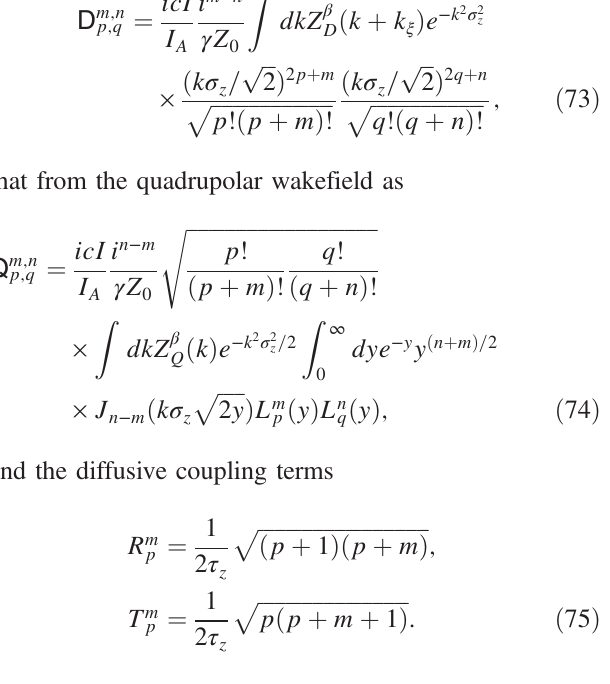
ffiffiffi p 2 Þ 2 p þ m ffiffiffiffiffiffiffiffiffiffiffiffiffiffiffiffiffiffiffiffiffiffiffi